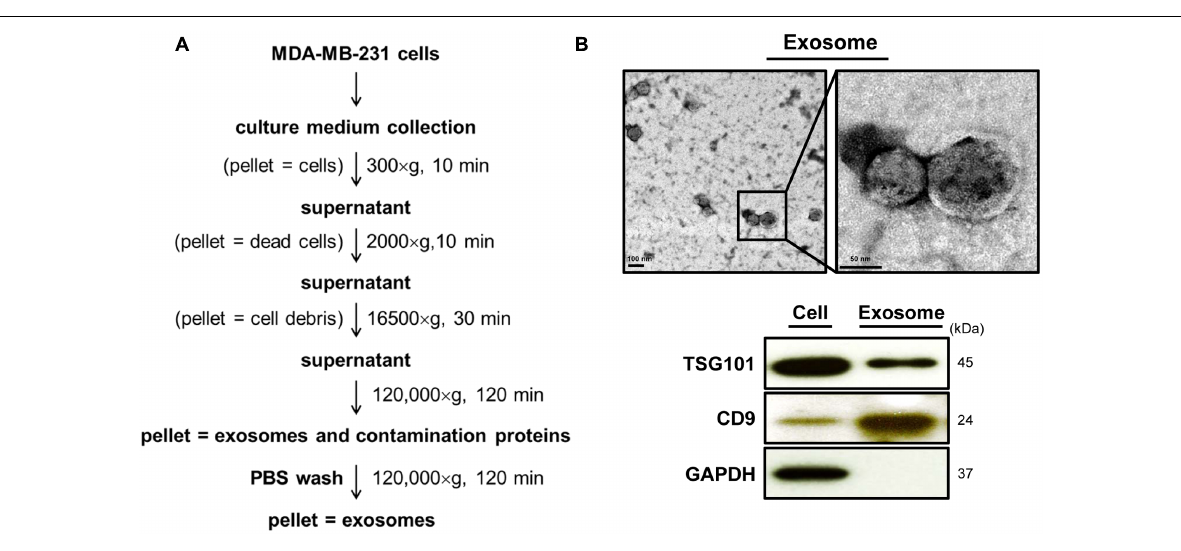
FIGURE 3 | Characterization of the quality of MDA-MB-231 cell-derived exosomes. (A) Flow chart of cell-derived exosome isolation and purification from culture medium by differential centrifugation. (B) Purified exosomes from the 24-h vehicle–treated TNBC cells were examined using transmission electron microscopy (TEM) imaging (9,900 × and 19,500 × magnification). Immunoblotting of exosomal marker proteins, TSG101 and CD9, from the same batch of exosomes. GAPDH was used as a positive control of cytosolic